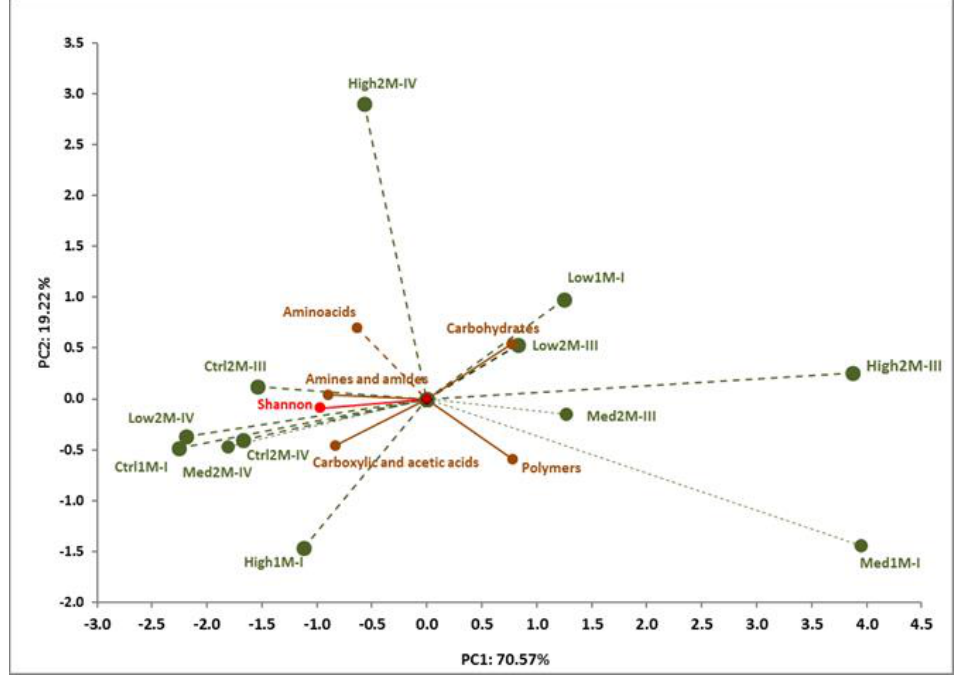
Figure 3. Heat map of the metabolic profile of microorganisms based on the use of various C sources using the EcoPlate method after 144 h of incubation. Ctrl, Low, Med, High—optimal moisture and low, medium and high water stress, respectively; 1M, 2M—month of the experiment; I, III, IV—sampling time.